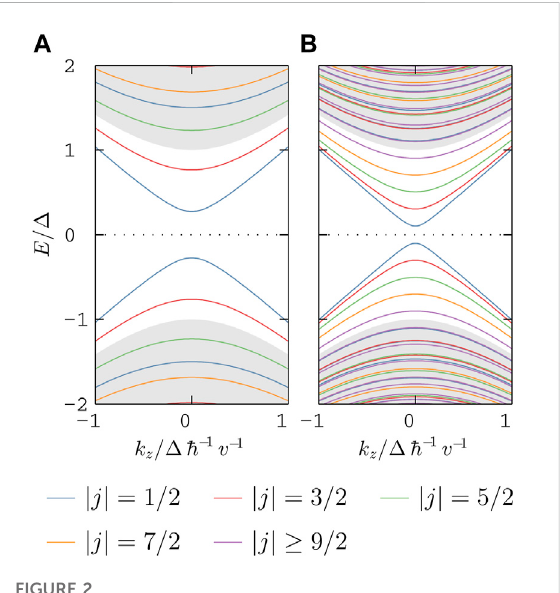
FIGURE 2 Energy spectrum labeled by the quantum number | j | of two uniform nanowires of (A) R = 2.5 Z v / Δ and (B) R = 5.5 Z v / Δ . Bulk subbands are indicated within the shadowed region while surface bands lie within the energy gap of the bulk